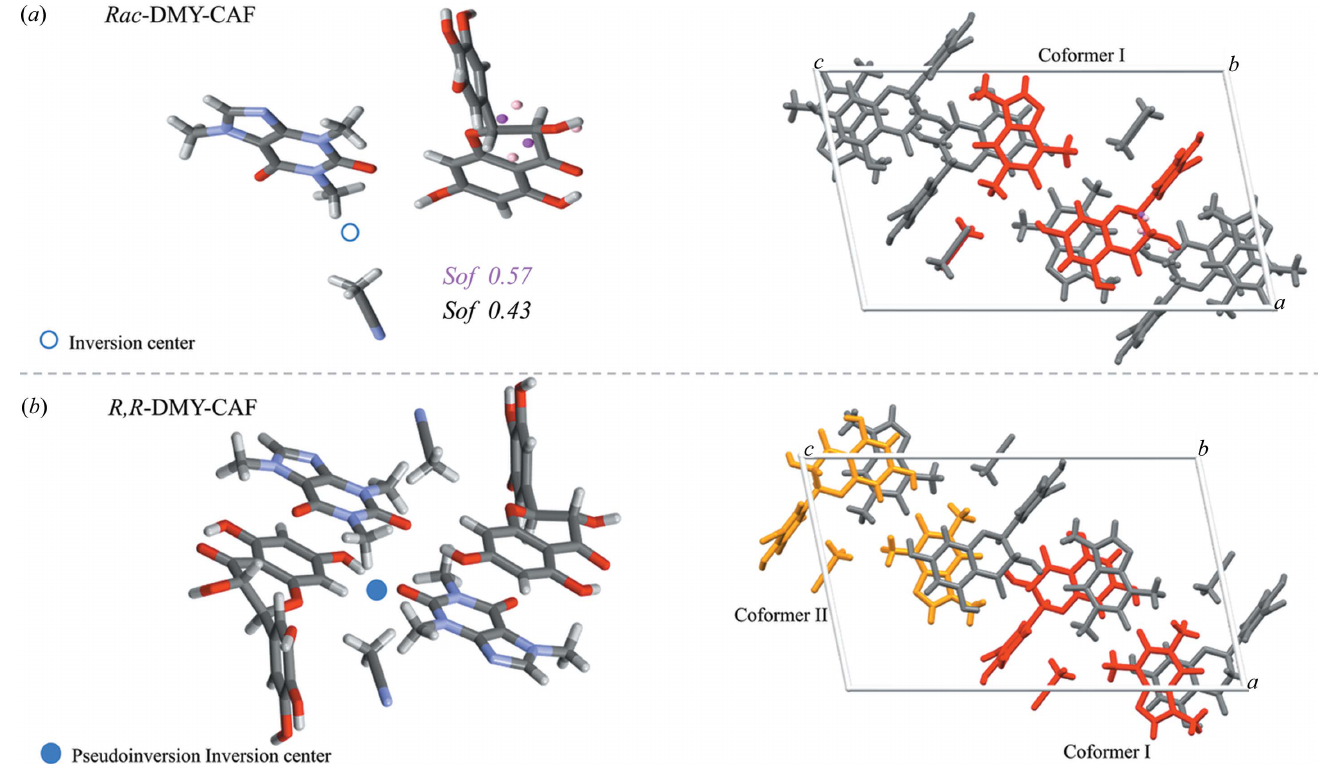
Figure 3 Asymmetric units and unit cells of ( a ) Rac -DMY–CAF ( P 2 1 / n , Z 0 = 1, Z 00 = 3) and ( b ) R , R -DMY–CAF ( P 2 1 , Z 0 = 2, Z 00 = 6).